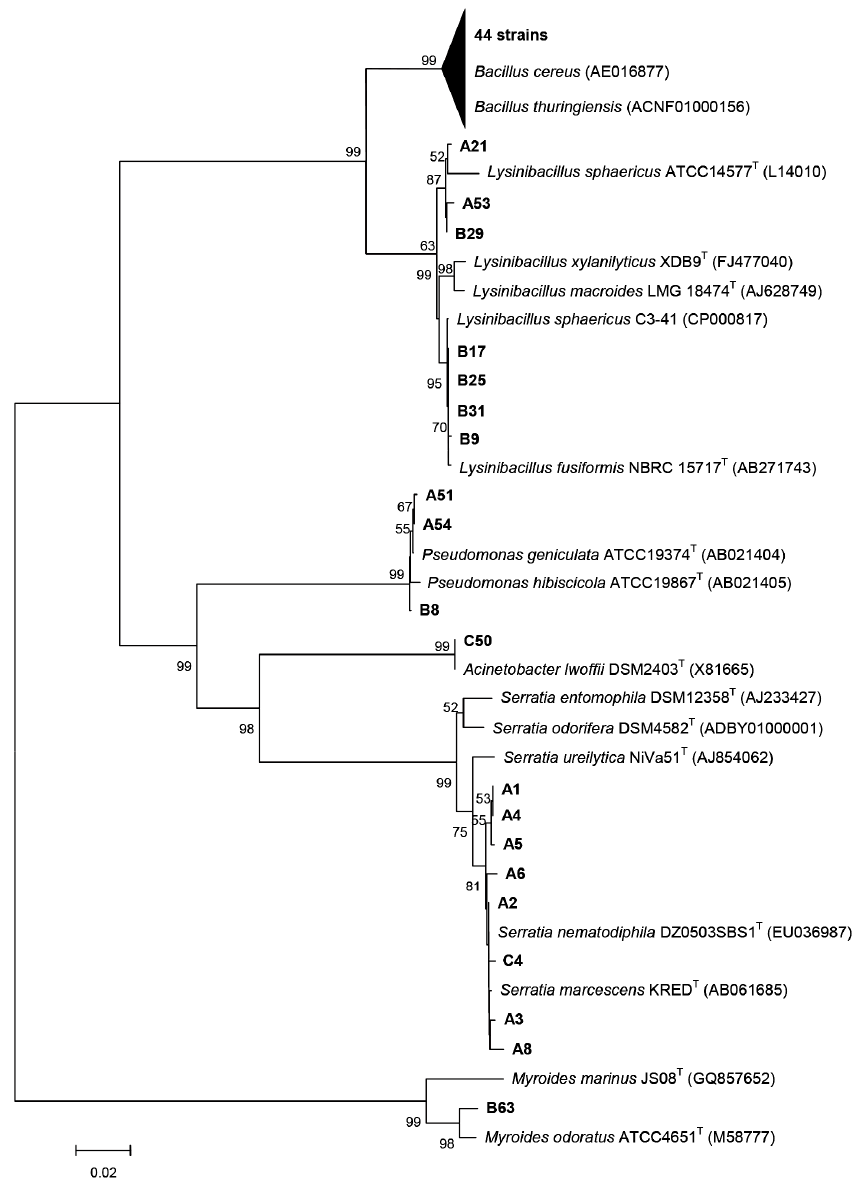
Figure 3. Phylogenetic relationship of the AHL-degrading phyllosphere isolates. The tree was constructed using the neighbor-joining method based on the 16S rRNA gene sequences of the isolates and reference taxa. The bacterial isolates in this study were shown in bold type. Accession numbers are indicated after the name of the reference sequences. The values represent the relative proportions that a branch appeared in 1000 bootstrap replications. Scale bar, 0.02 relative sequence